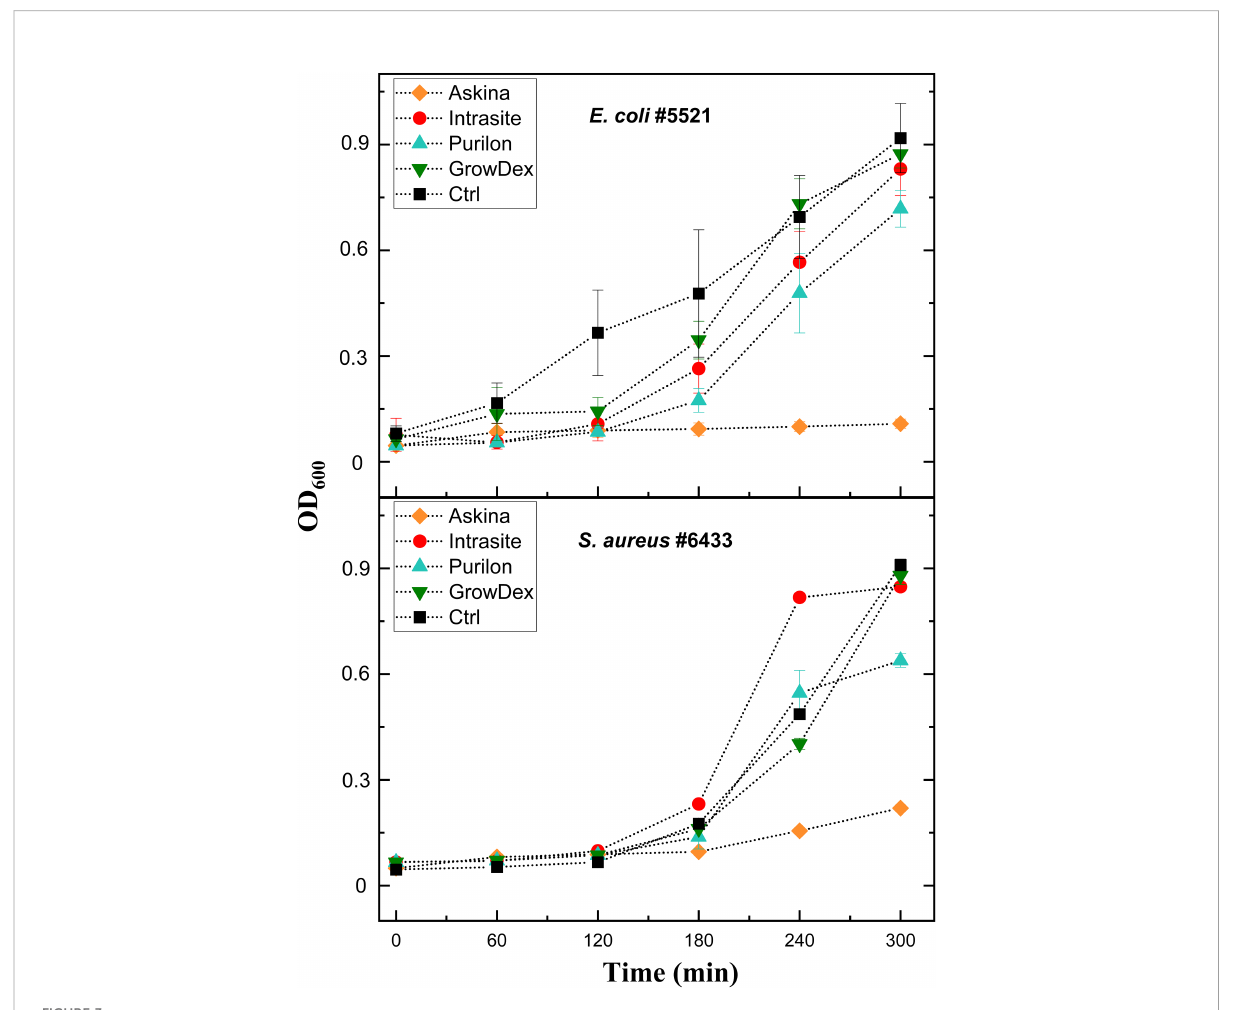
FIGURE 3 The effect of four commercial hydrogels on bacterial growth. Hydrogels Askina, Intrasite, Purilon, and GrowDex were added into bottom of the microtiter well plates as 10 µl droplets. Overnight cultures of E. coli strain #5521 and S. aureus strain #6433 were diluted 1:500 and 1:100, respectively. 200 µl of these bacterial dilutions were added into the wells, and the plate was incubated at 37°C and 200 rpm for fi ve hours. Absorbance at 600 nm was measured at one-hour intervals. Bacteria grown in lysogeny broth without hydrogel served as control. Each sample was analyzed in triplicate, and the mean and SD are